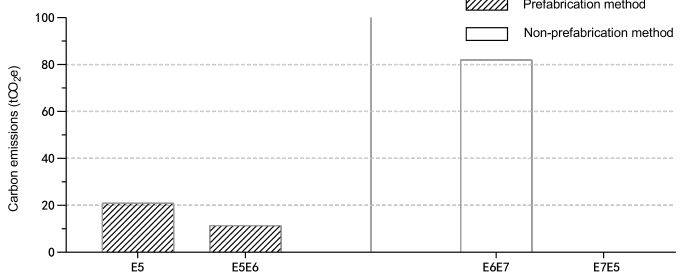
Figure 11. Comparison of carbon emissions during the construction phase of Building B1.